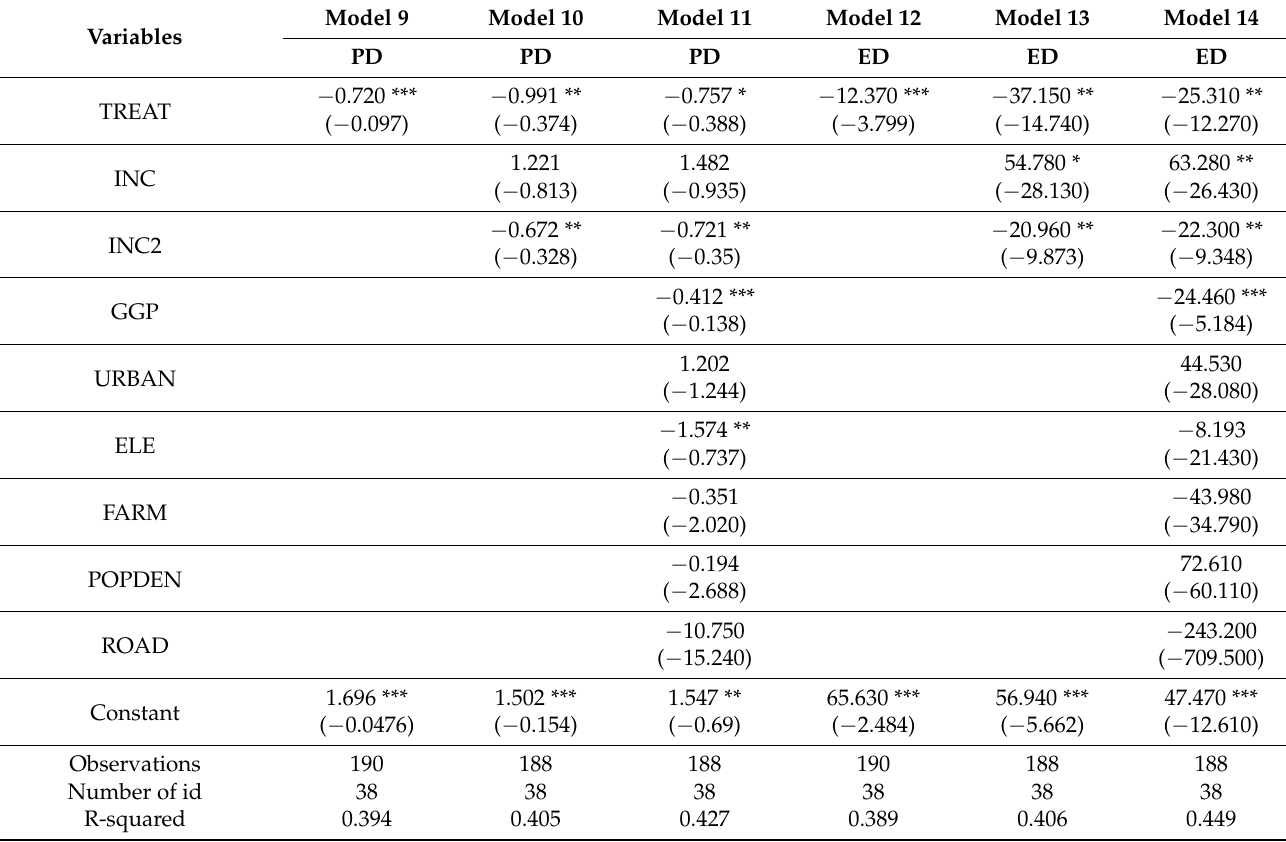
Table 5. Robustness